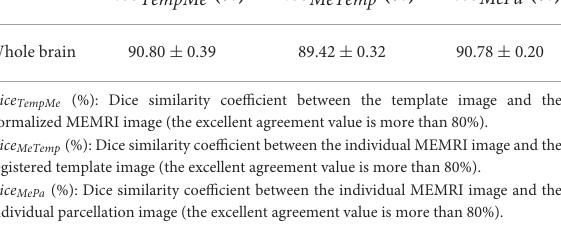
TABLE 1 Volumetric and spatial correspondence